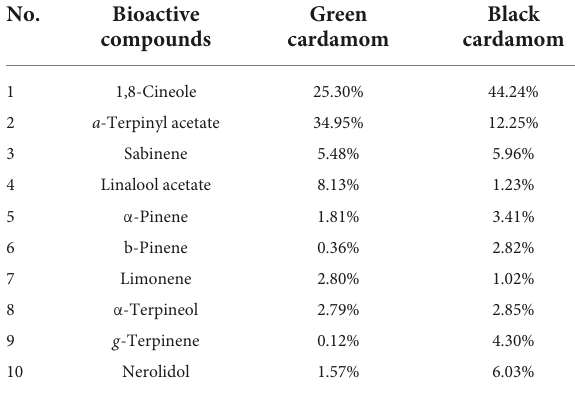
free radicals were scavenged by cardamom